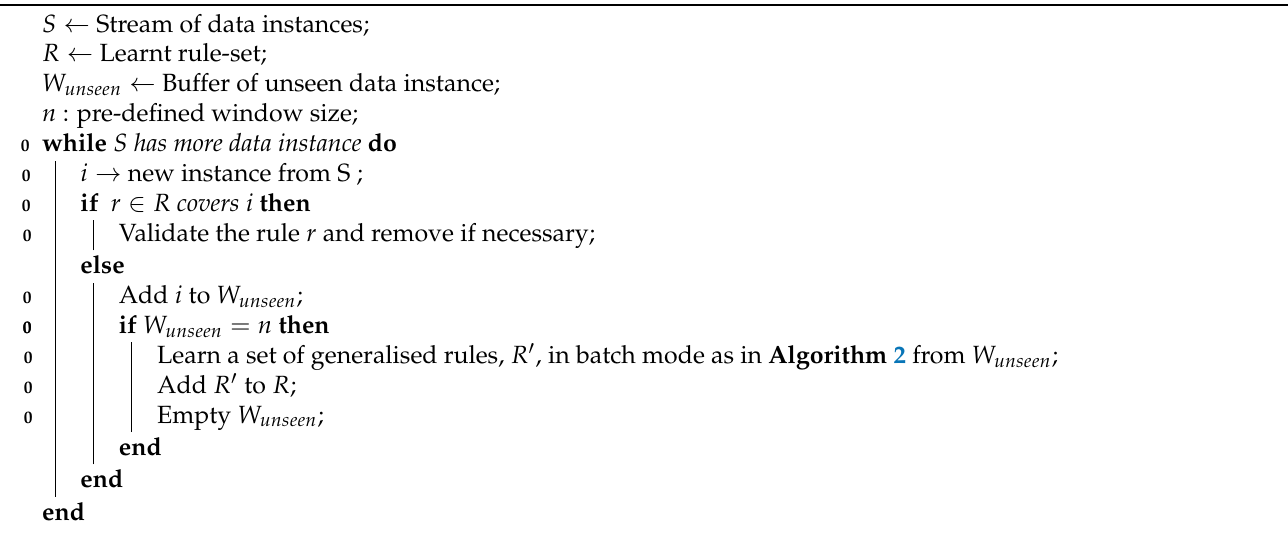
Algorithm 3: Fast Generalised Rules Induction from Streaming Data.